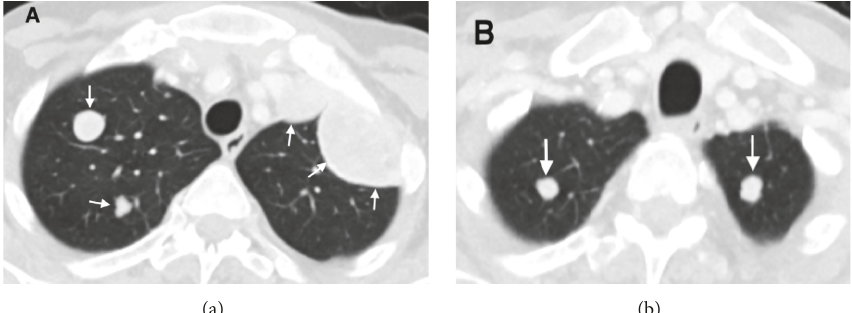
Figure 1: Axial contrast-enhanced computed tomography (CT) scan of chest showing bilateral multiple lung metastases (white arrows) prior to nivolumab treatment.